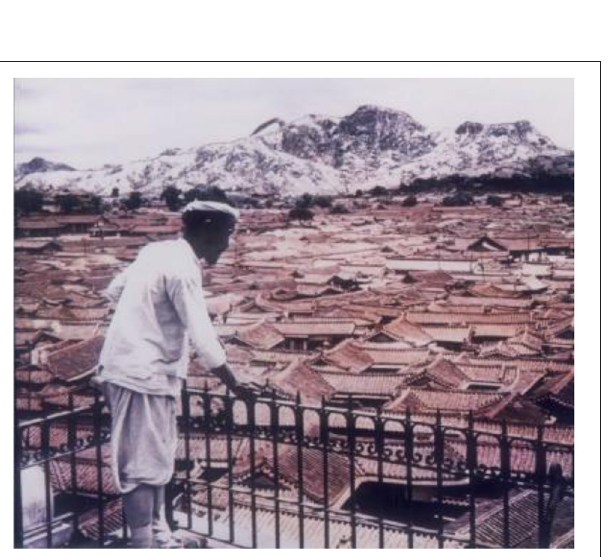
FIGURE 2 | Photograph of Seoul from the Sontag Hotel, c. 1902, close to the location of Antoinette Sontag’s rooftop sighting of an urban leopard. Photographer unknown. Reproduced courtesy of JoongAng Ilbo. Note the high level of urban development and the density of